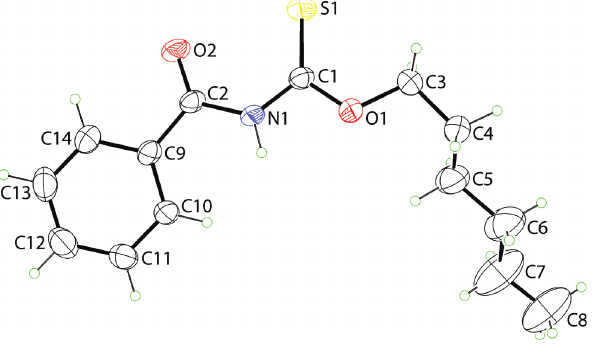
Table 1: Data collection and handling.